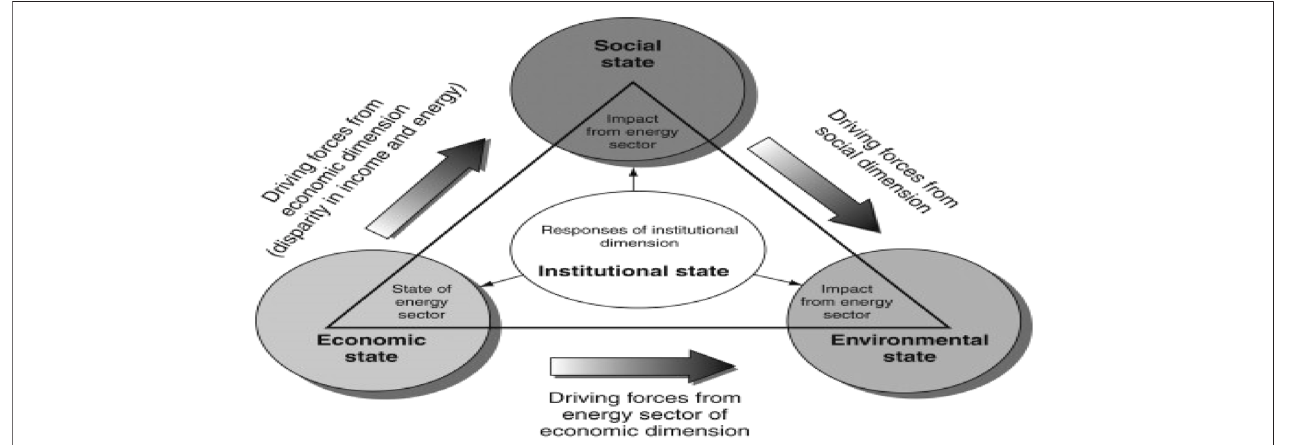
FIGURE 7 | The dimensions of sustainability and their interrelationships (Kolagar et al., 2020).